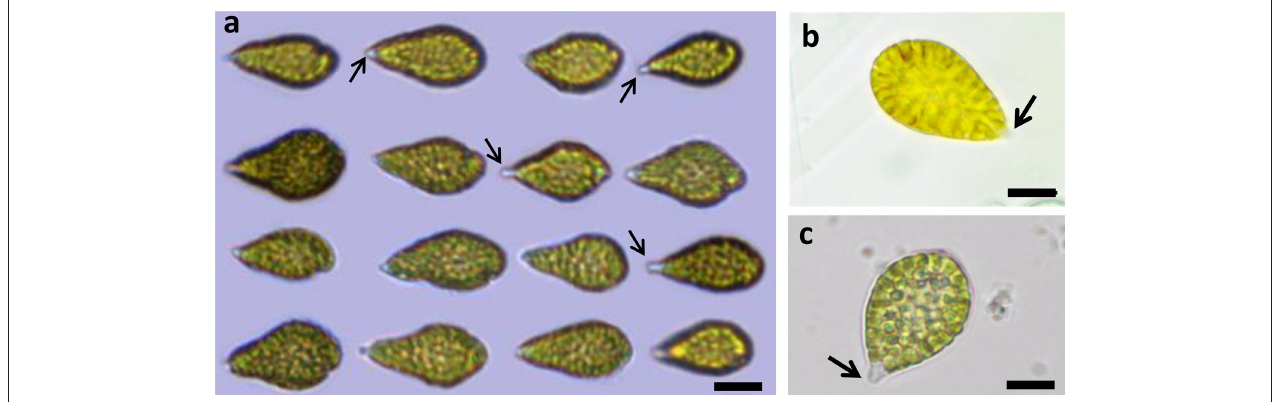
FIGURE 4 | Live C. subsalsa cells from plankton samples collected in Guanabara Bay. (a) Live cells imaged by the FlowCam ® ; (b,c) Live cells observed in an inverted mircroscope at 40X magnification. The hyaline, tail-like protrusion at the posterior end of the cells typical of C.subsalsa can be seen (arrows). Scale: a: 10 µ m, b and c: 20 µ